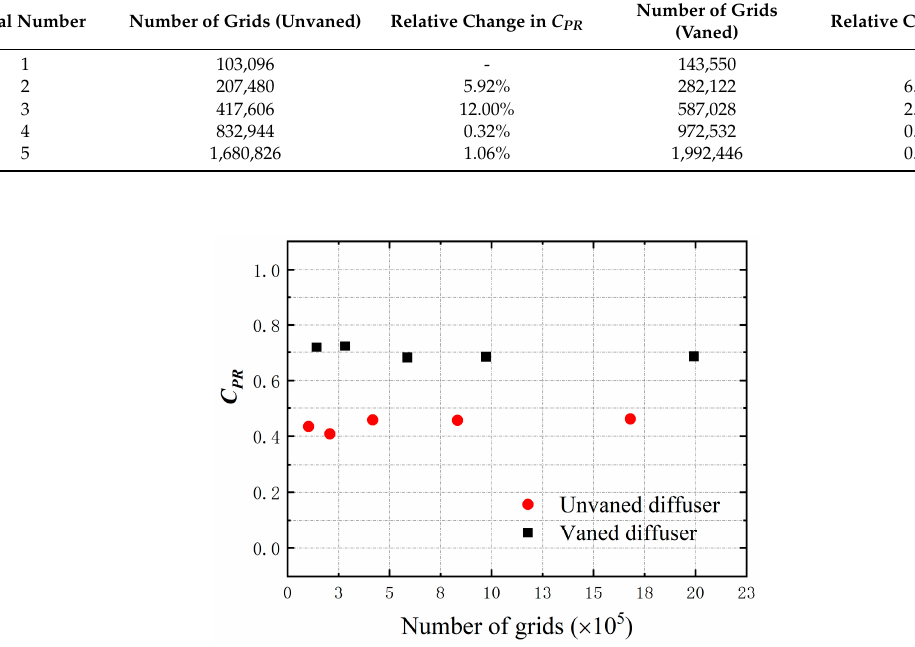
Figure 5. Grid independence test.